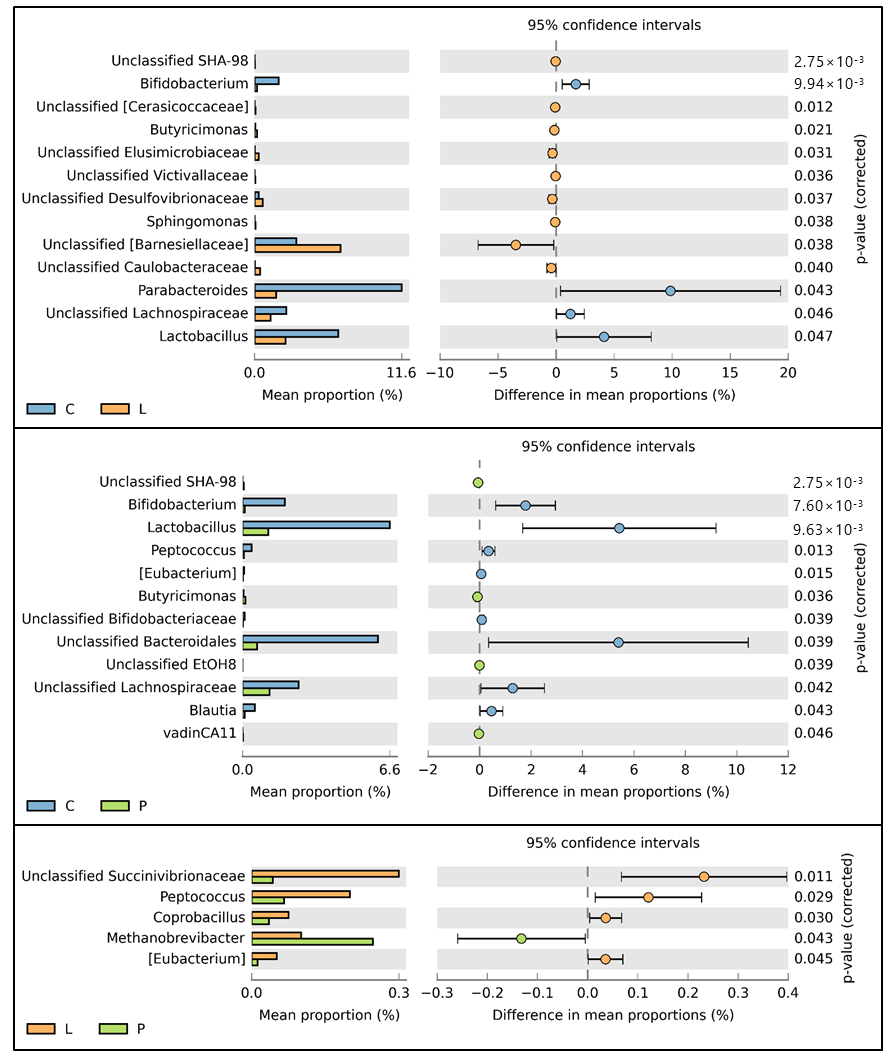
Figure 4. Comparative analysis of the taxonomic composition of microbial communities at the genus level (C: n = 9; L: n = 10; P: n = 10). Representative genera with significant differences between groups are indicated by the histograms and P value determinations, as calculated by STAMP software. C: control diet; L: larvae diet; P: pre-pupae diet.